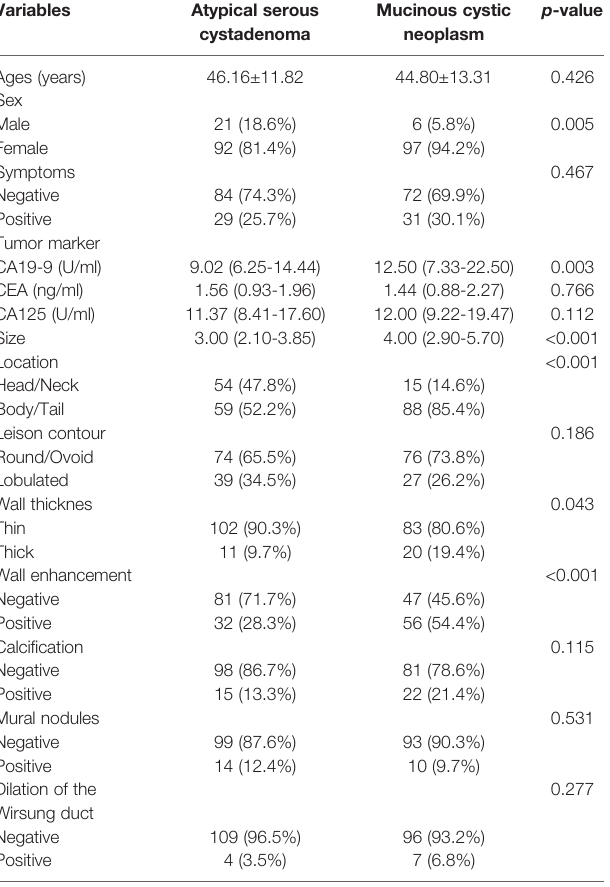
Chi-Square tests were used to compare the difference in categorical variables (sex, symptoms, location, lesion contour, wall thickness, wall enhancement, calci fi cation, mural nodules, and dilation of the Wirsung duct). A two-sample t-test was used to compare the difference in age. A Mann-Whiney U test was used to compare the difference in serum tumor makers and tumor size. CA19-9, carbohydrate antigen 19-9; CEA, carcinoma embryonic antigen; CA125, carbohydrate antigen 125.